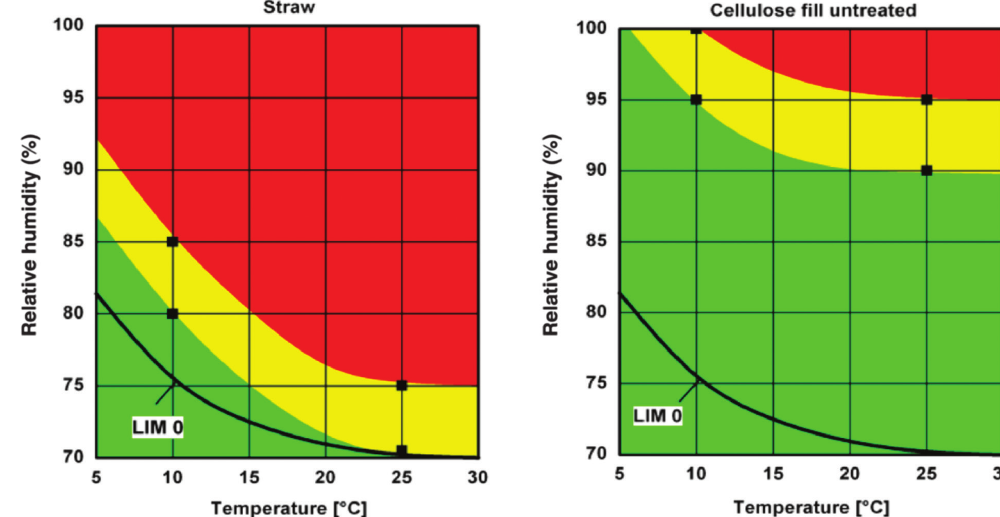
Mould growth sensitivity of two building insulation materials illustrated by the RH–temperature range of growth probability. Green indicates no growth risk, yellow low growth risk and red high growth risk